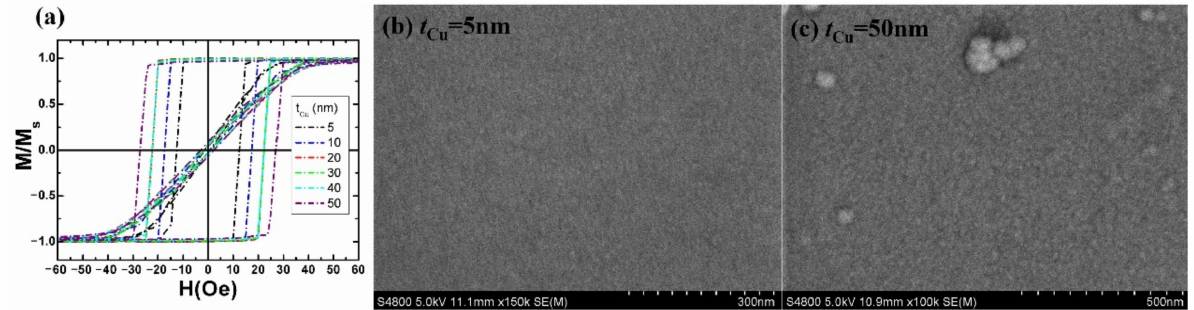
Figure 2. ( a ) The hysteresis loops along both easy axis and hard axis dependence on t Cu . ( b , c ) are SEM photos of samples with thickness of 5 nm and 50 nm,